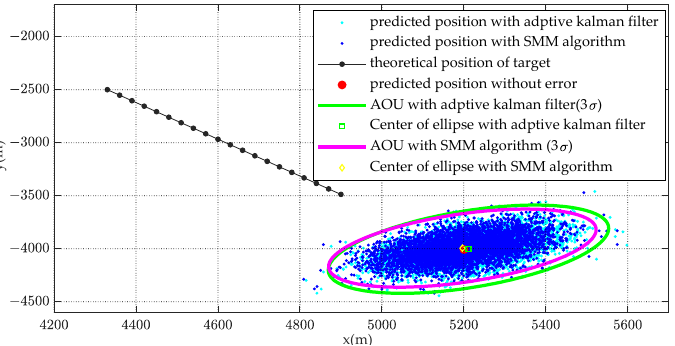
Figure 12. AOU coverage with 20,000 simulated random points.